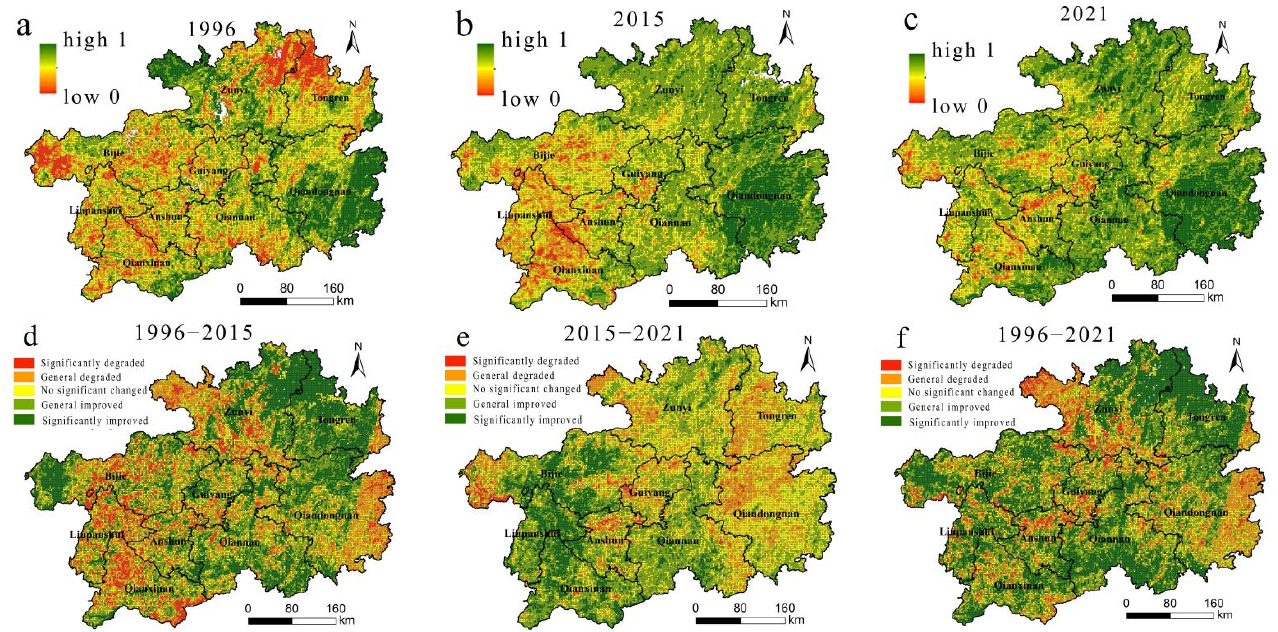
Figure 7. EEQ dynamics change during the study period. ( a ) The current EEQ in 1996; ( b ) The current EEQ in 2015; ( c ) The current EEQ in 2021; ( d ) The spatial variation of RSEI over 1996–2015; ( e ) The spatial variation of RSEI over 2015–2021; ( f ) The spatial variation of RSEI over the whole study period (normal indicates 1 rank change, significant indicates 2 and more rank changes).